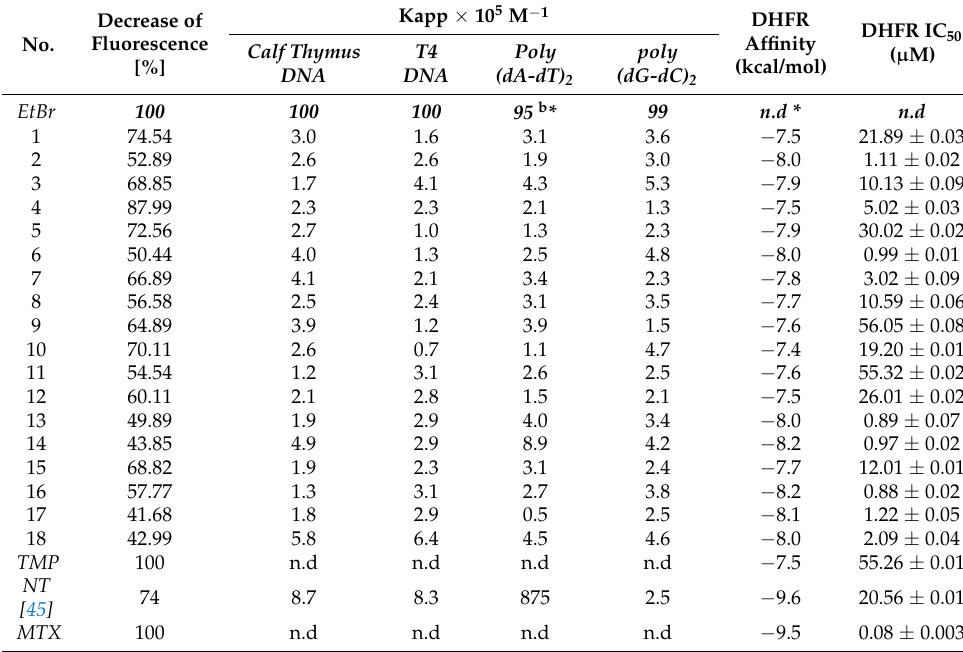
Table 1. DNA-binding effects, association constants (Kapp), dihydrofolate reductase (DHFR) in- hibitory affinity, and the activity of TMP, MTX, NT [48], and the new series of TMP analogs 1–18 . Decrease of No.